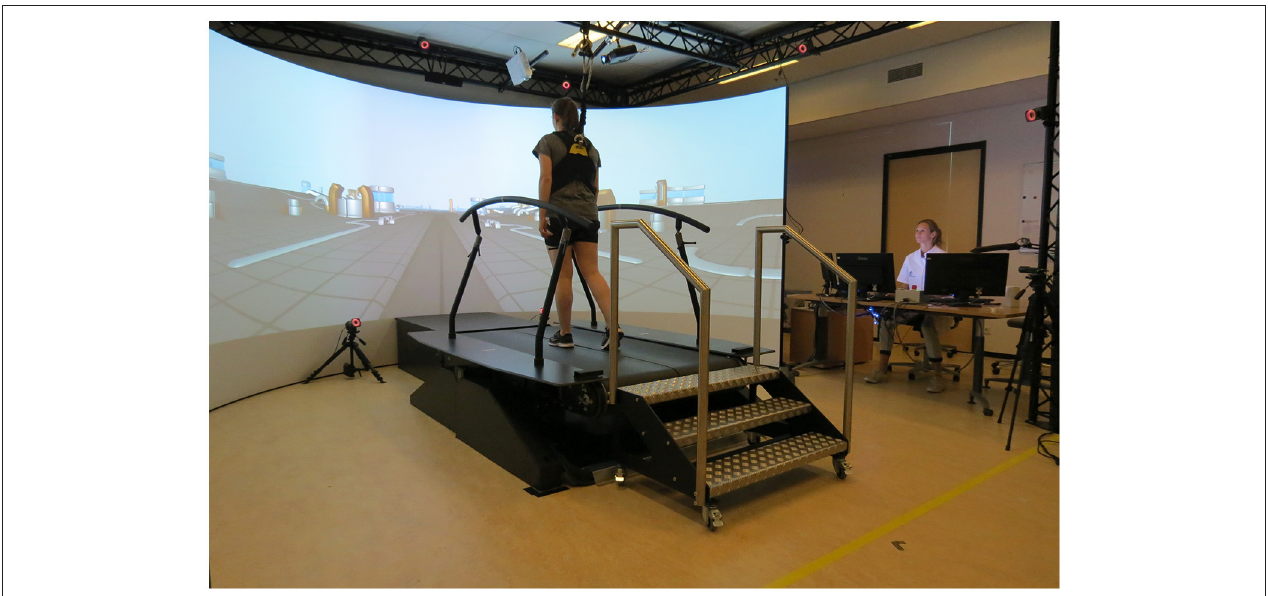
FIGURE 1 | Gait Real-time Analysis Interactive Lab (GRAIL) at the Sint Maartenskliniek. Both persons have given their written and informed consent for publication of the picture.